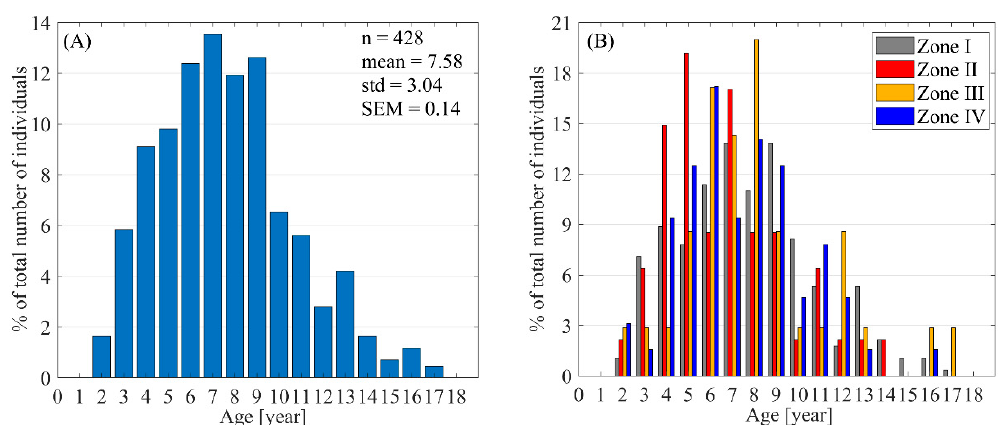
Figure 11. Age distribution of females at Patelnia Point calculated based on the power model of female body length and age: BL = 1.67*age 0.20 for October 27 ( A ), where BL stands for female body length, and normalized class categorization of female age based on the power model for all four zones ( B ).